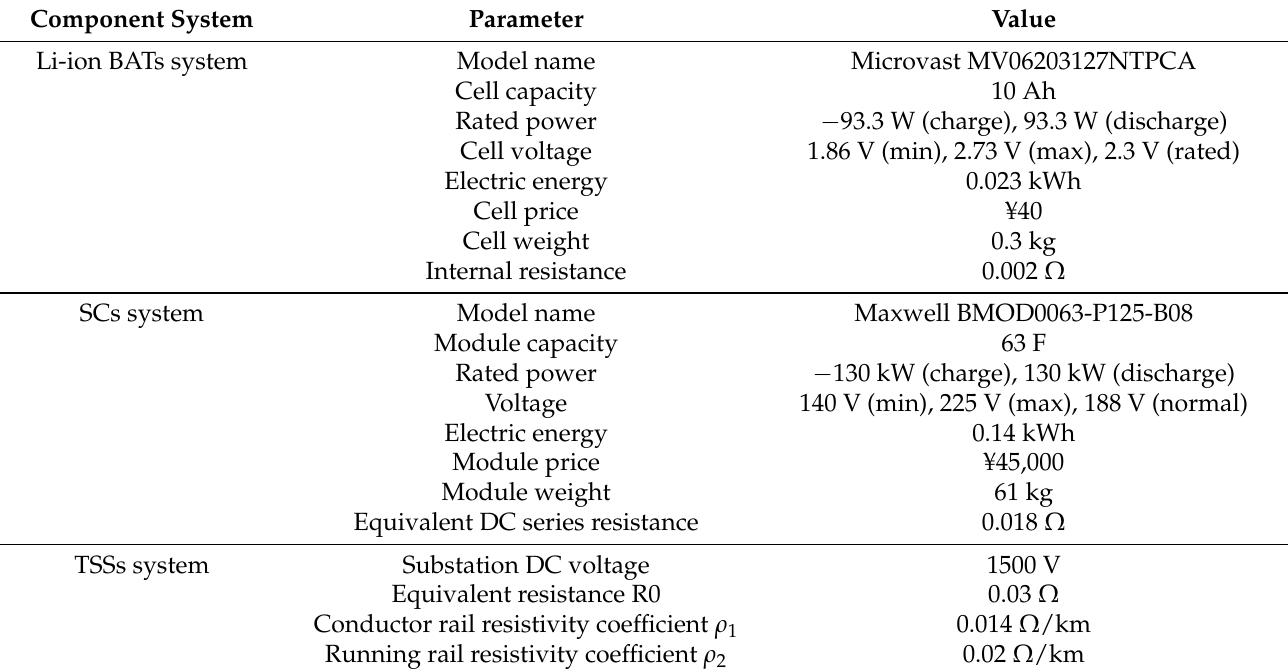
Figure 1. A schematic diagram for an electric train with on-board HESDs in DC traction supply network. Table 2. Specifications of the on-board HESDs and TSSs for a typical electric train